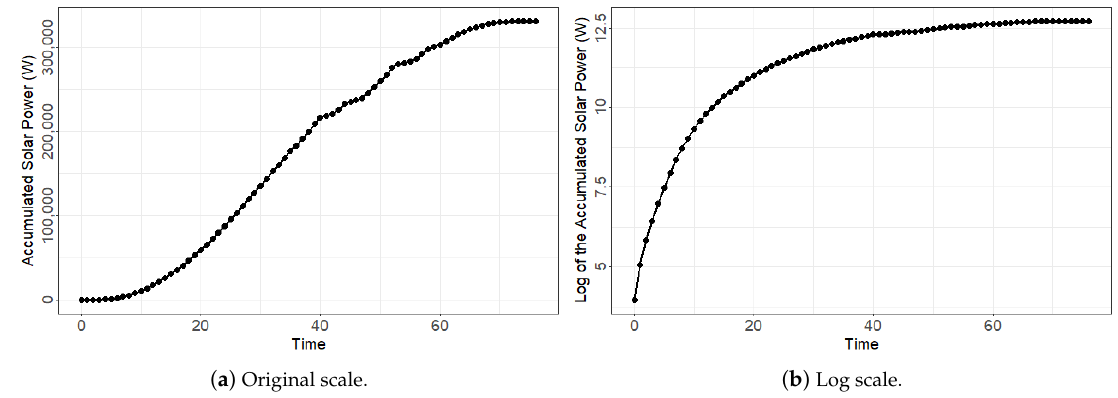
Figure 5. The generated solar power on day